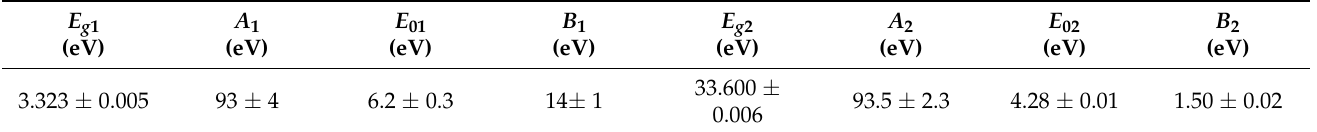
Figure 5. Comparison of Raman spectra for raw xerogel and xerogel annealed at 500 °C for 60 min. Table 1. Parameters of the Tauc–Lorentz model fit to experimental